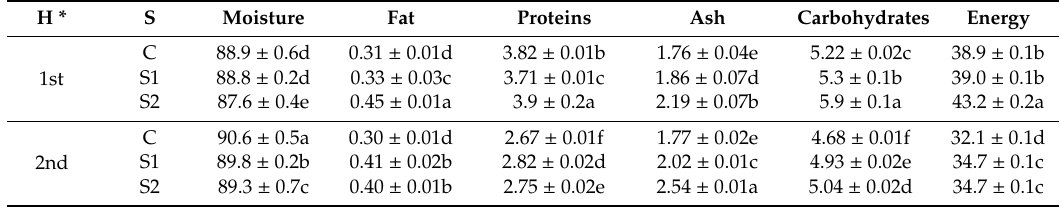
Table 2. Nutritional value (g / 100 g fresh weight (fw)) and energetic value (kcal / 100 g fw) of Centaurea raphanina subsp. mixta leaves in relation to harvesting time (H) and salinity level (S) (mean ± SD, n =